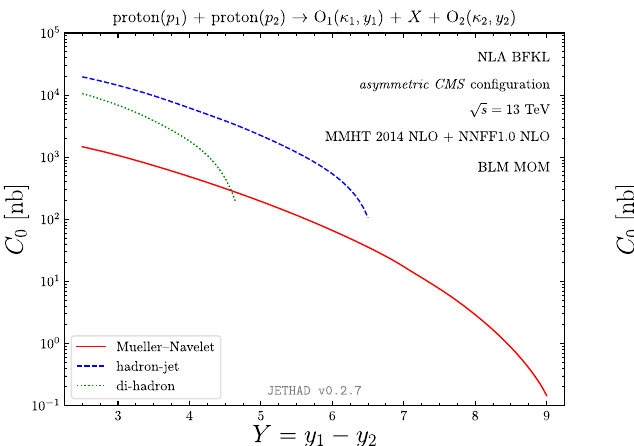
given in the left (right) panel. Hadron emissions, when considered, are described in terms of NNFF1.0 [190] NLO FF parametrizations (see Sect. 2.4 for further